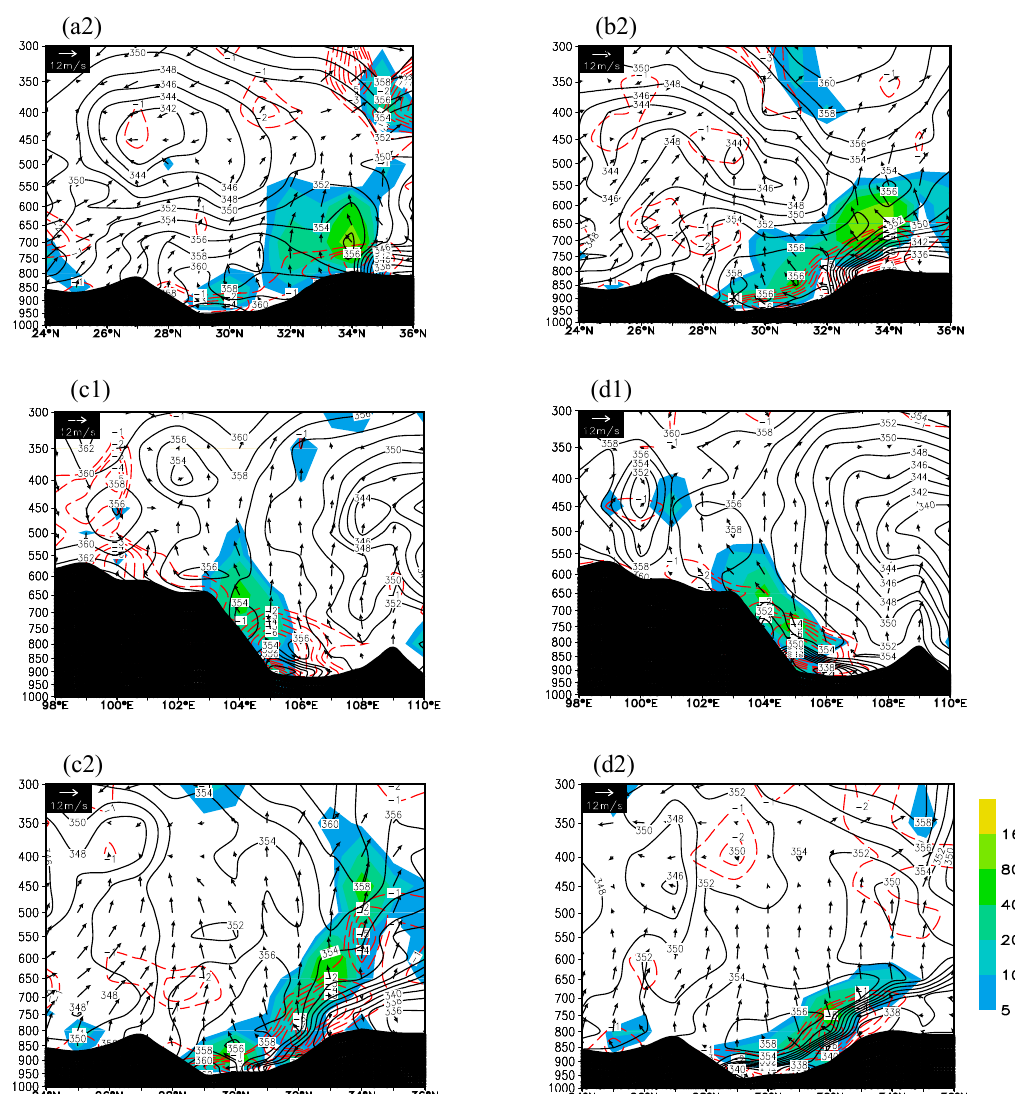
Figure 7. The vertical helicity (shaded, 10 − 6 Pa/s 2 ), pseudo-equivalent potential temperature (contours, K), negative divergence (red dashed lines, 10 − 5 /s), and horizontal wind (m/s) distribution ( a1 – d1 ) vertical section along 32 ◦ N; ( a2 – d2 ) along 105 ◦ E; ( a1 , a2 ) 1800 UTC 7 July; ( b1 , b2 ) 1800 UTC 8 July; ( c1 , c2 ) 1800 UTC 9 July; ( d1 , d2 ) 1800 UTC 10 July. Black areas: terrain.